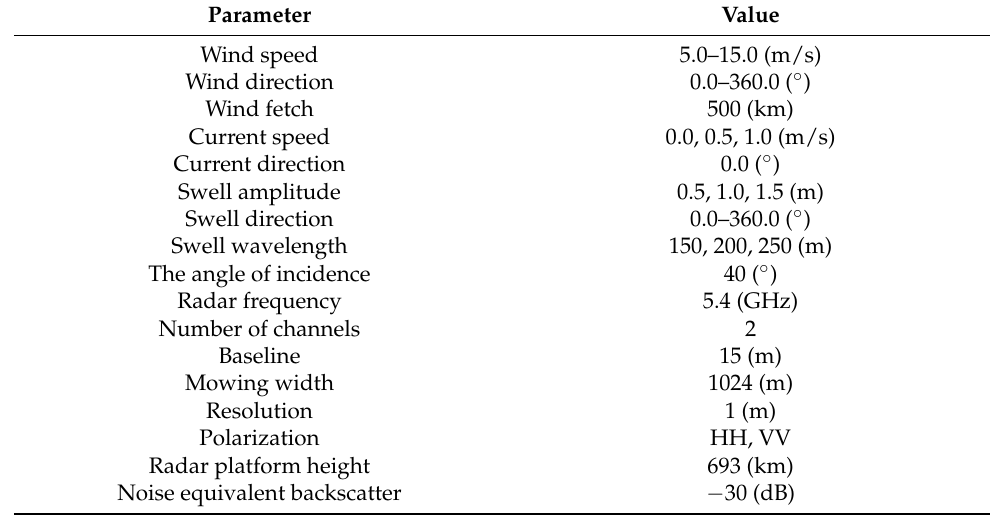
Table 1. Values of input parameters for the ATI SAR measurement of sea surface current velocity.